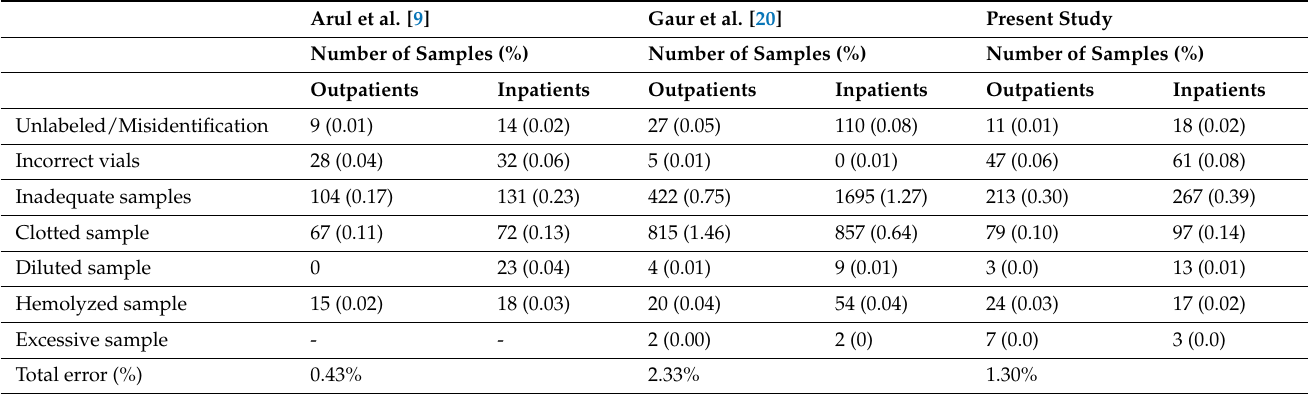
Table 5. Comparison of error frequency and types with other studies between OPD and IPD